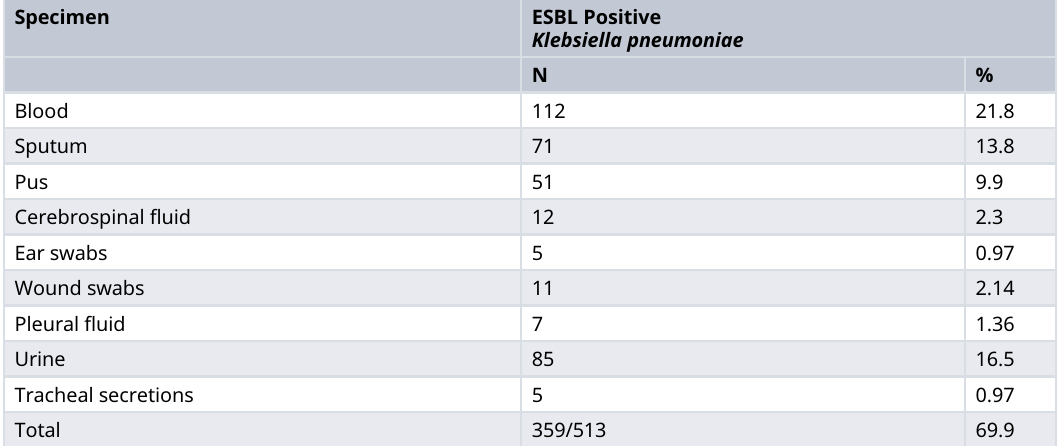
Table 3. Frequency of ESBL - K. pneumoniae in various clinical specimens (n =